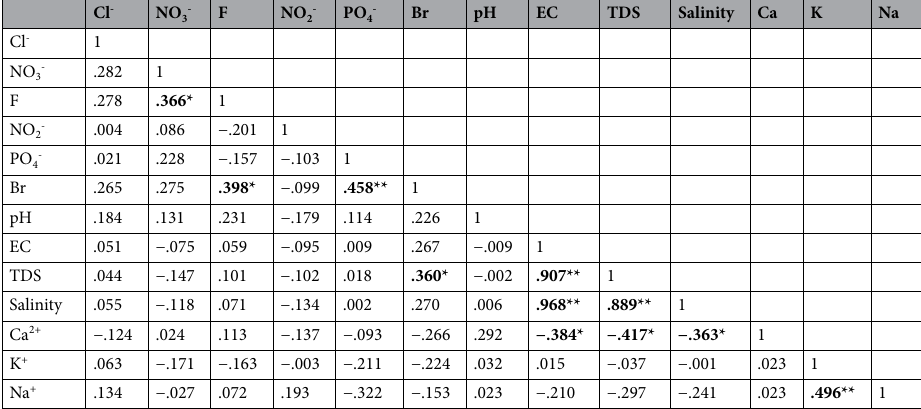
Spatial distribution pattern. Figure 2a–g represents the spatial distribution pattern of different water quality parameters in the location maps of sample collection area. Figure 2a represents the spatial distribution pattern of the pH, which indicates that the central part along with NE-WS across the district shows the alkaline nature of surface water. On the other hand the NE-NW along with the central part represents the acidic nature of water. According to previous reports, fluoride is absorbed on a clay surface in acidic water,and desorbed in alkaline water. Hence, for fluoride dissolution, alkaline pH is more favorable 37,38 . The EC in the district is in the range of 136.1µS/cmto 1361µS/cm(Fig. 2b). The TDS is also low in the central and NE-NW-SE-SW parts of the Tawang (Fig. 2c). This shows that the EC and TDS have a significant positive correlation as evidence by the